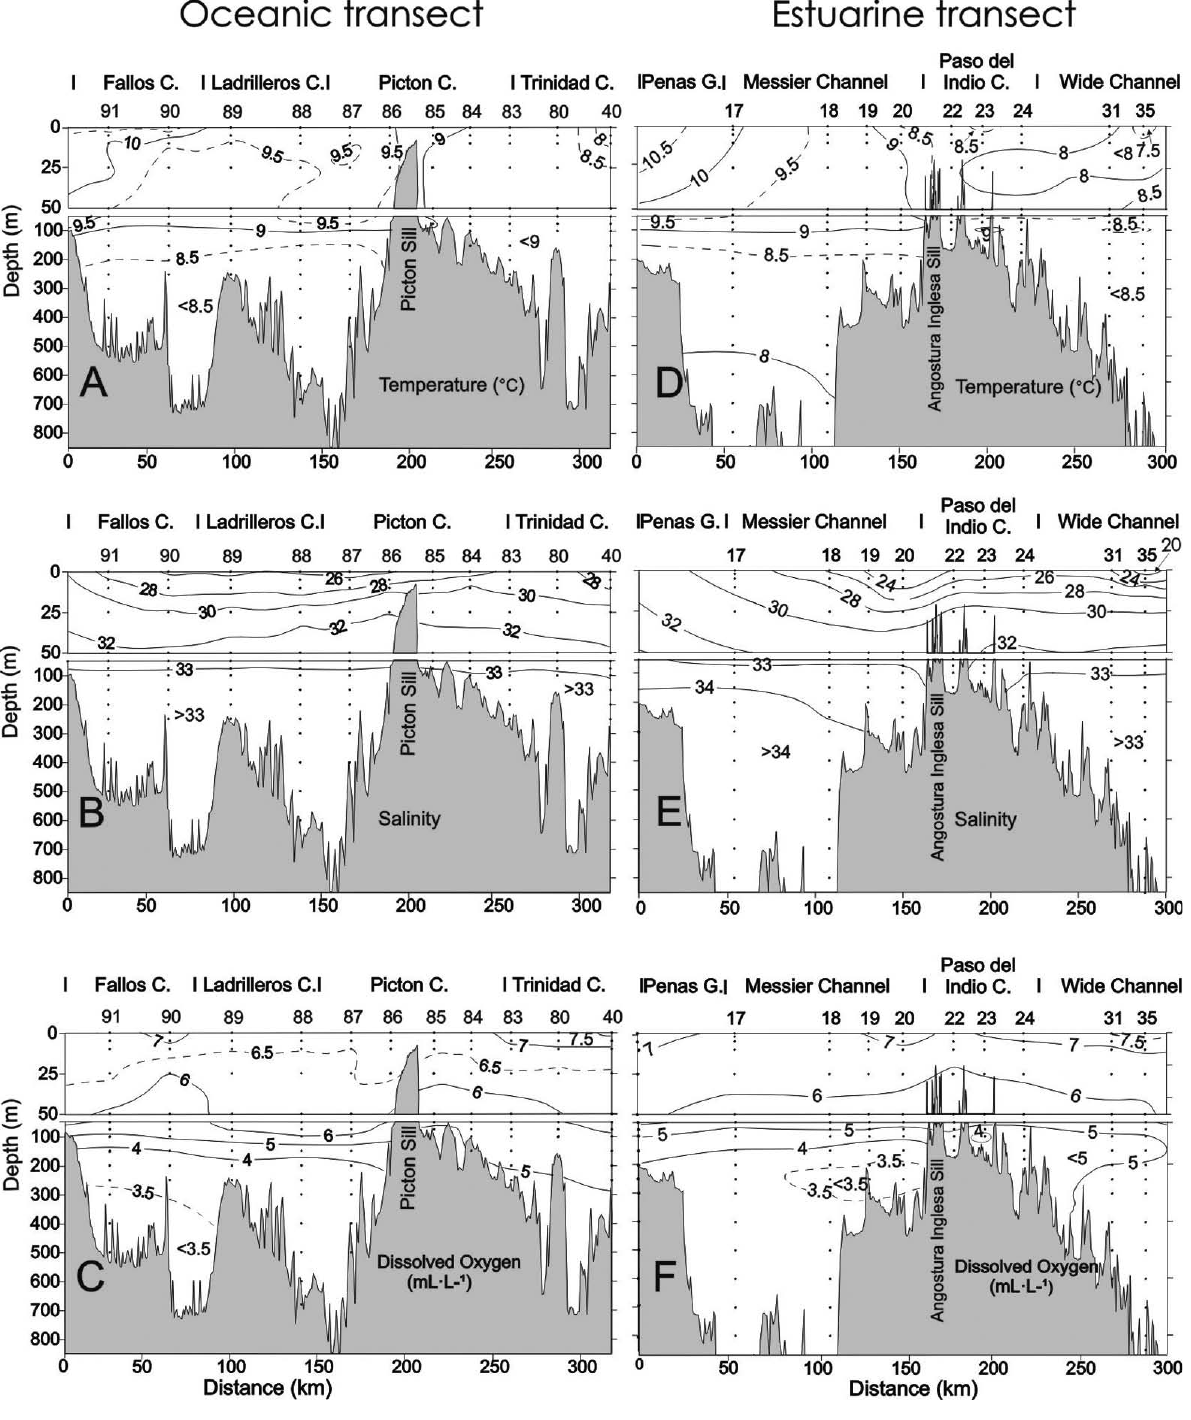
Fig. 2. – Vertical distribution of temperature (A), salinity (B) and dissolved oxygen (C) in the longitudinal oceanic transect (OT) and tem- perature (D), salinity (E) and dissolved oxygen (F) in the longitudinal estuarine transect (ET) between Penas Gulf and Trinidad Channel in spring